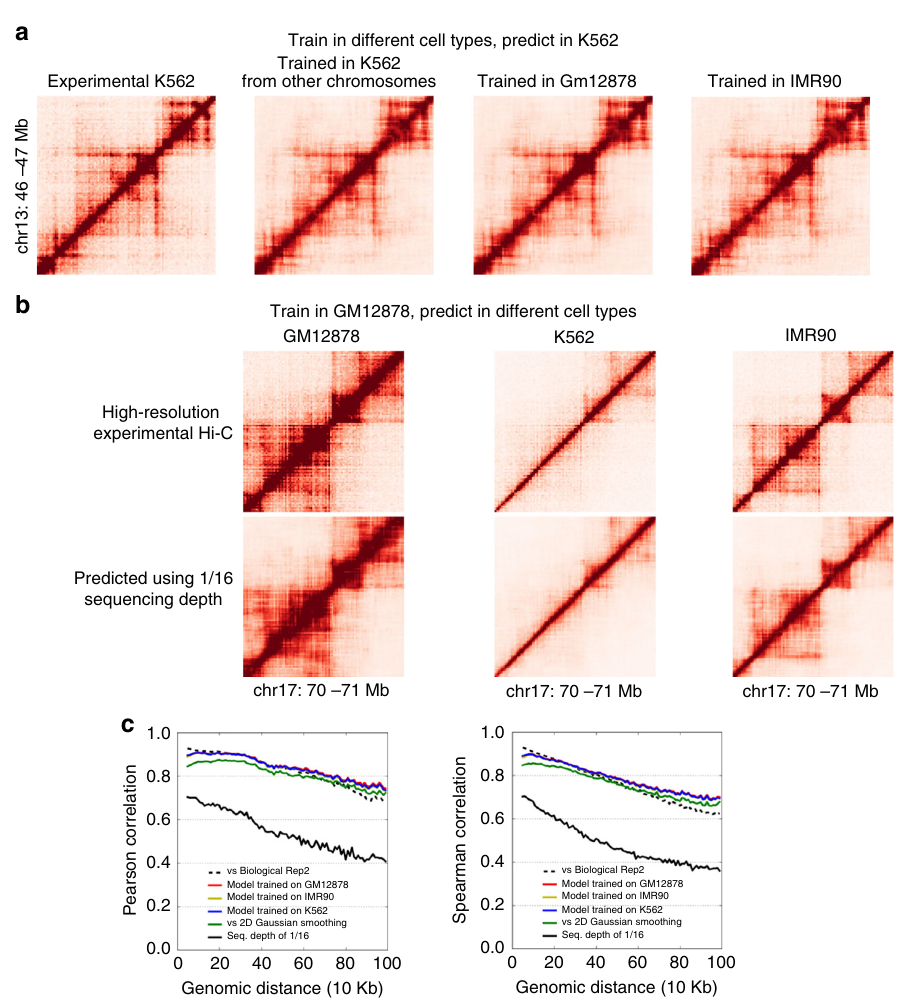
Fig. 4 HiCPlus can learn model from one cell type and predict in other cell types. Shown in the fi gures are real and HiCPlus-enhanced matrices in GM12878, K562 and IMR90 at 10 kb resolution. a HiCPlus-enhanced matrices in K562 with models trained in three different cell types are highly similar to each other, and all of them are also similar to the original K562 interaction matrix. b Model trained in GM12878 can be used to predict interaction matrices in different cell types (K562, GM12878 and IMR90). c High correlations between HiCPlus-enhanced matrices using models trained in three different cell types, 2D Gaussian kernel and high-resolution Hi-C at each genomic